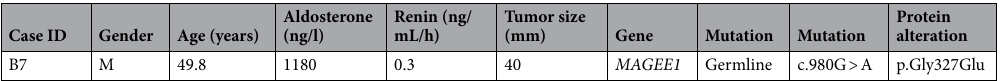
Table 1. Clinical characteristics of the patient with aldosterone producing adenomas and a germline mutation in MAGEE1 identified in this study.